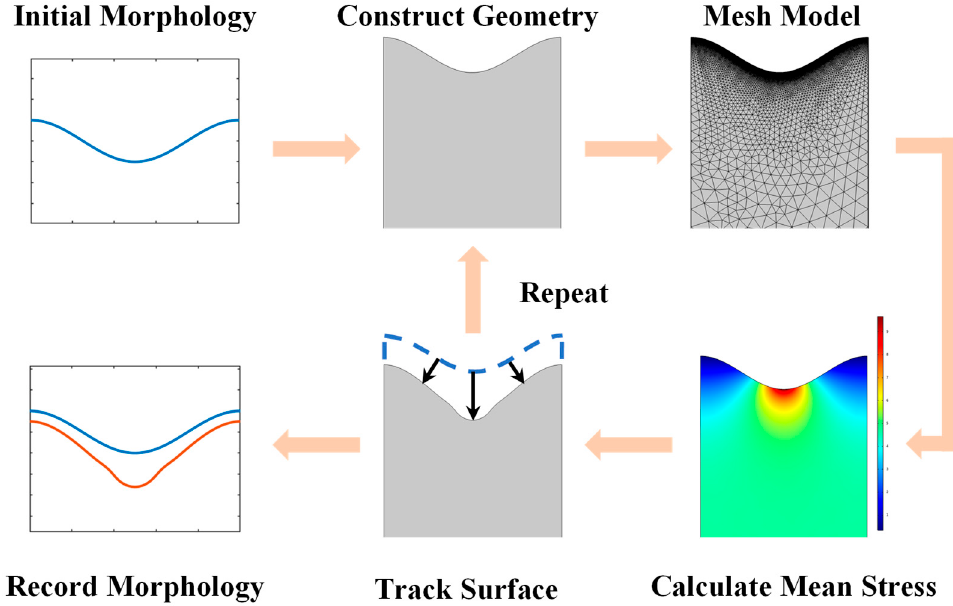
Figure 7. Simulation procedure of the morphology evolution under stress corrosion.